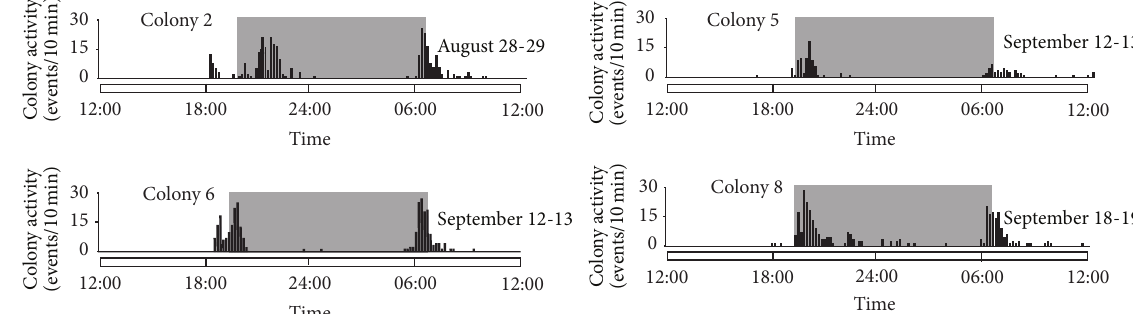
Figure 2: Activity records of field colonies of Hyphantria cunea caterpillars recorded in 1997. Grey rectangles indicate periods of darkness.